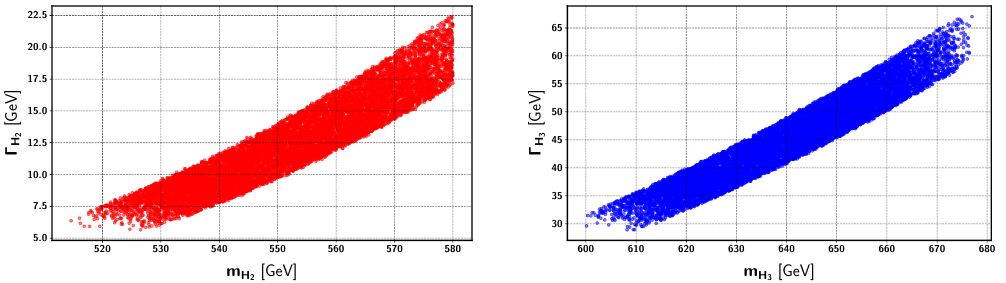
Figure 2 . Total decay widths for the scalars H 2 and H 3 , obtained from the very fine grained parameter space